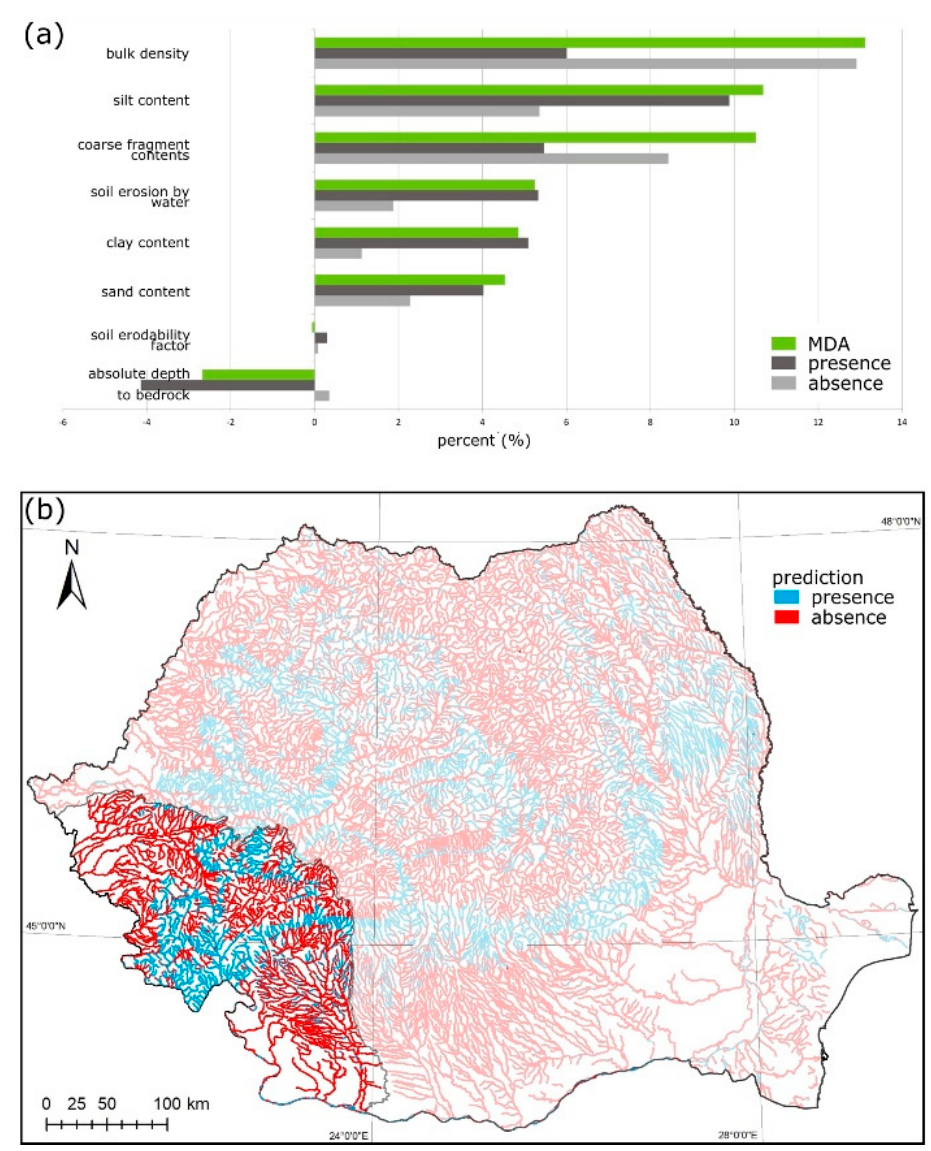
Figure 3. ( a ) Mean decrease in accuracy of soil-related factors for predicting Austropotamobius torrentium species distribution. ( b ) Prediction map of A . torrentium species distribution based on soil- related factors. A mask was applied to highlight results of prediction inside the area of distribution of this species.